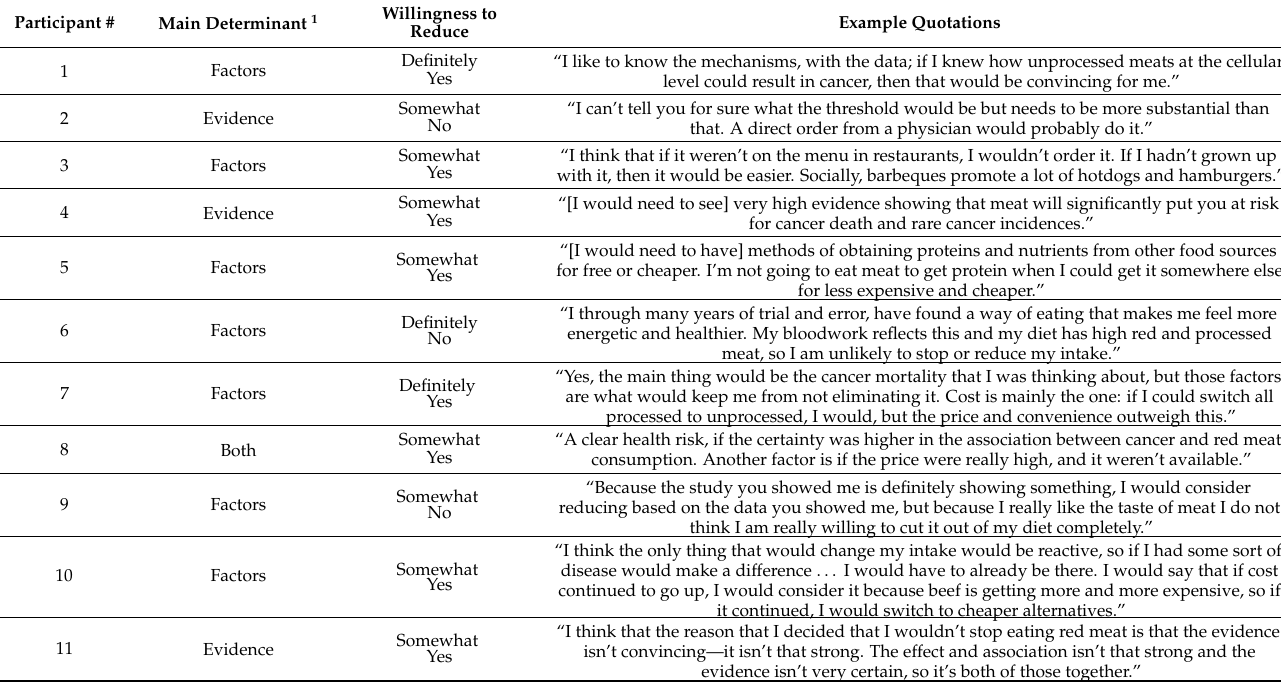
Table 3. Participant willingness to change their meat intake given the potential cancer risk and the main determinant(s) of their